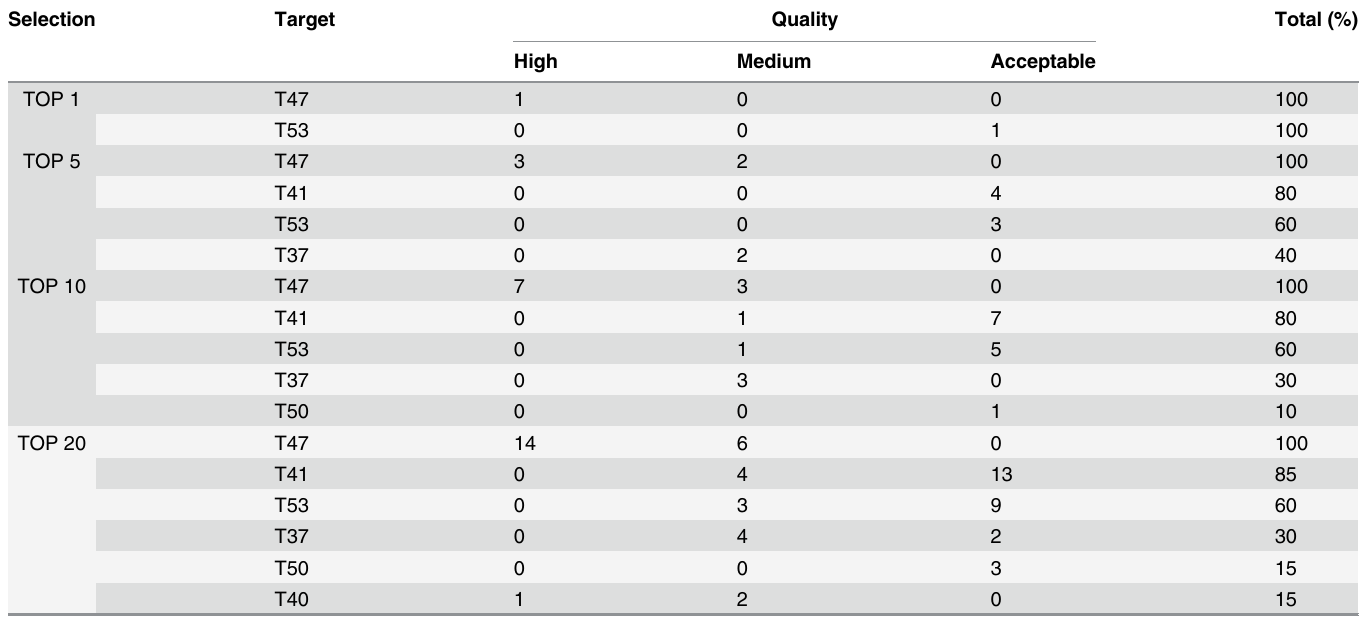
Table 1. Success selections of top ranked structures.